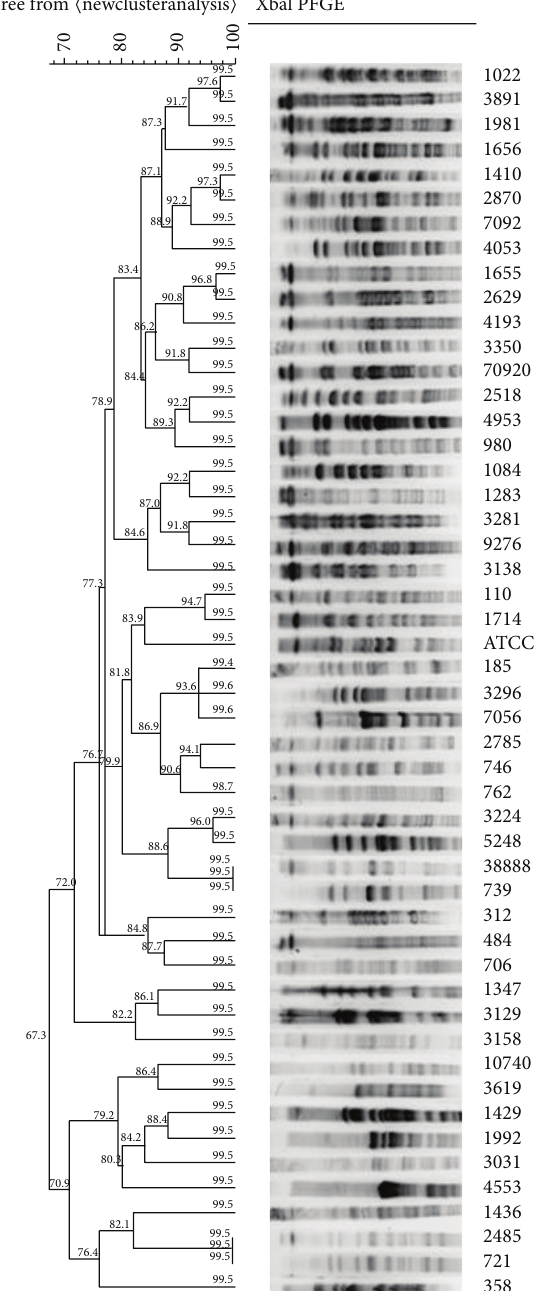
Figure 1: Pulsed-field gel electrophoresis dendrogram of UPEC isolates. The vertical black line shows the 80%